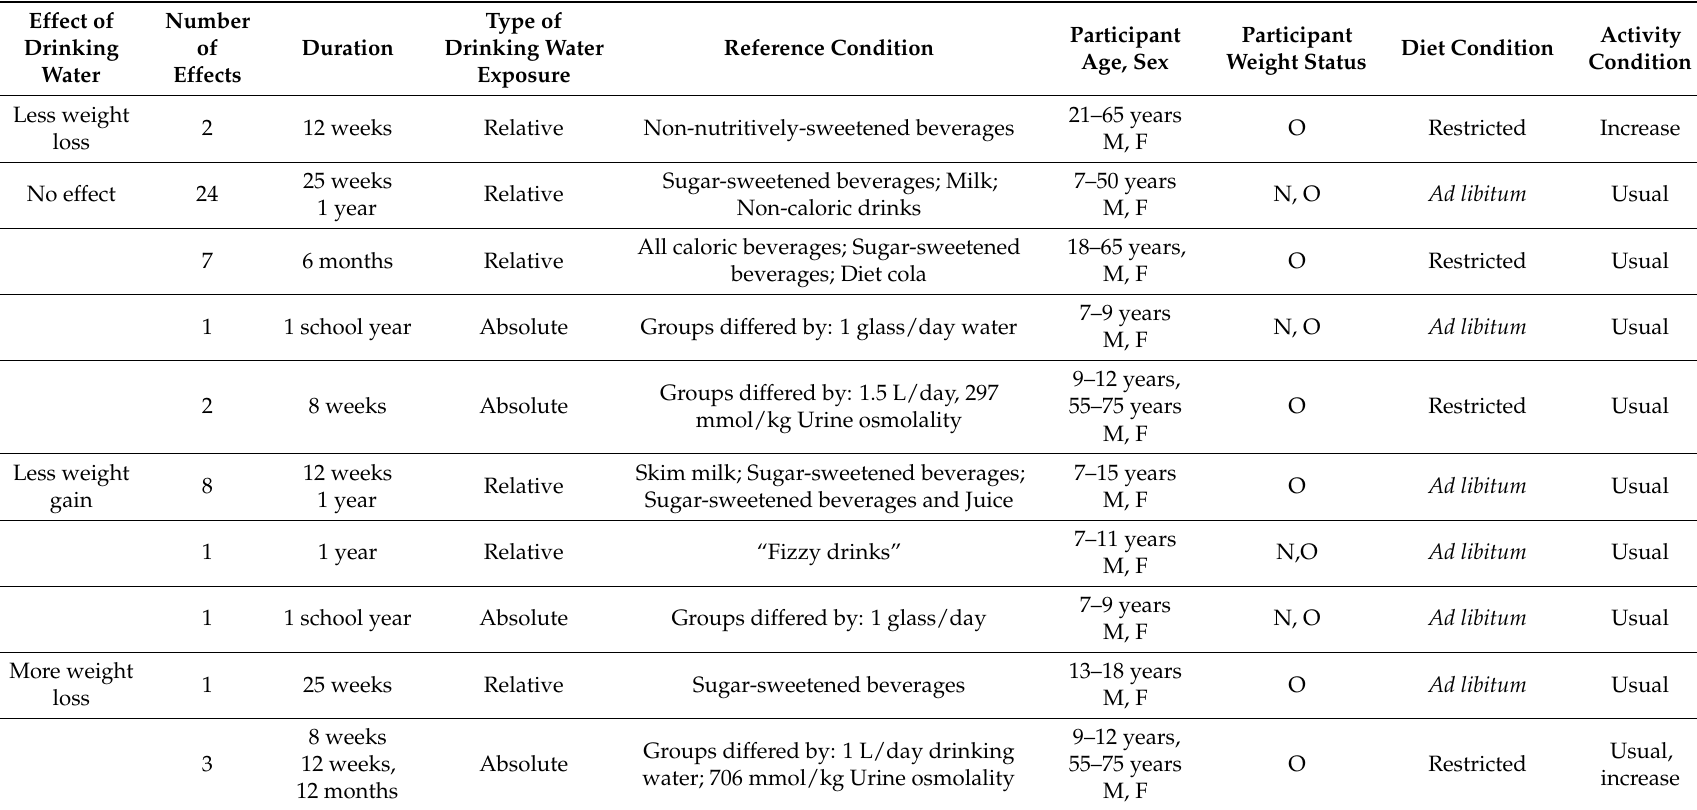
Table 5. Single-component RCT conditions associated with negative, null and positive effects of plain drinking water on weight